Question: Briefly state, in one sentence, what is plotted here.
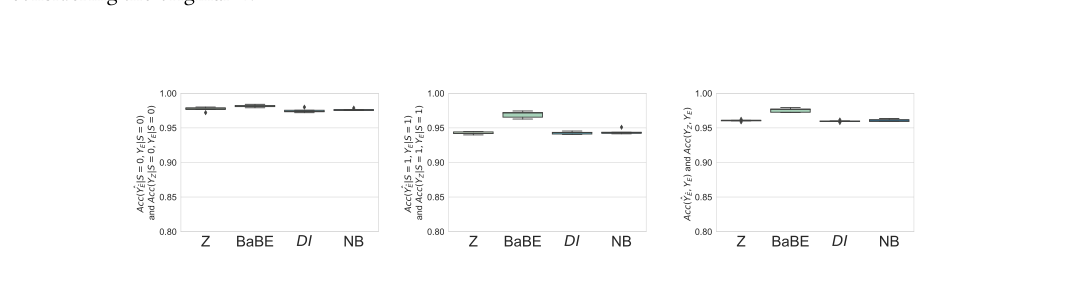
Answer: shows the accuracy resulting from the application of BaBE, DI, and NB to the NHANES data set. As we can